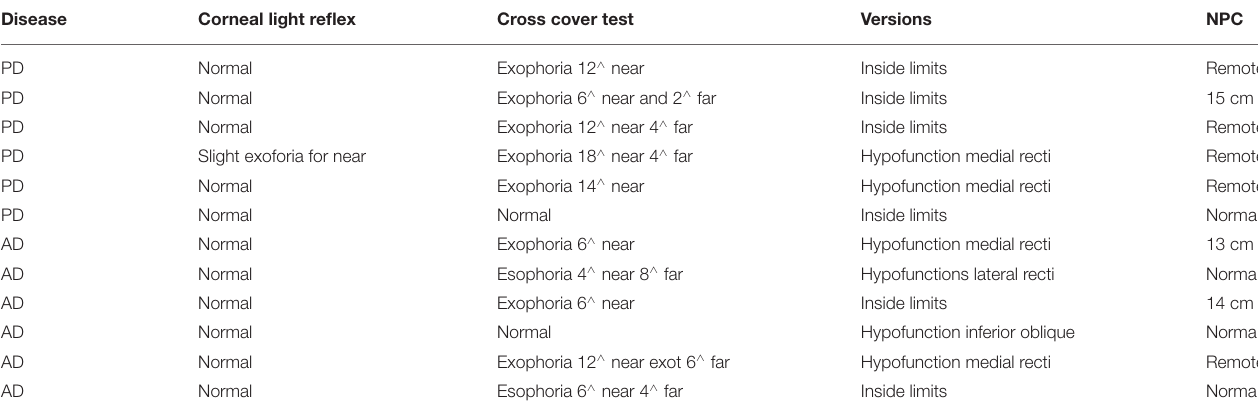
TABLE 1 | Orthoptic evaluation: Corneal reflexes for near and far, cross-cover test quantified by prismatic diopters, versions’ test to evaluate ocular motility and near point of convergence. Disease